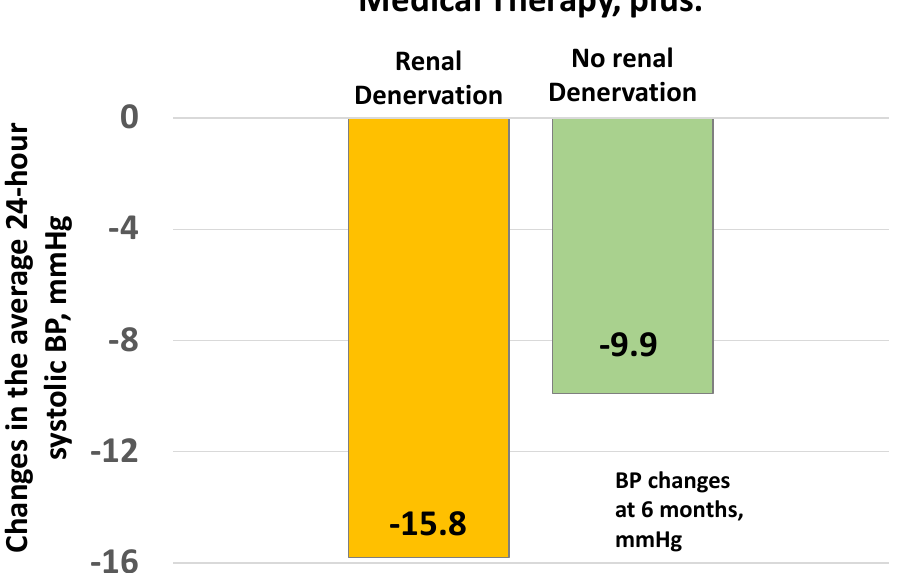
Figure 3. Changes in 24-h systolic BP at 6 months in patients with renal denervation and in a control group not receiving renal denervation. Adapted from Azizi and coworkers [91].